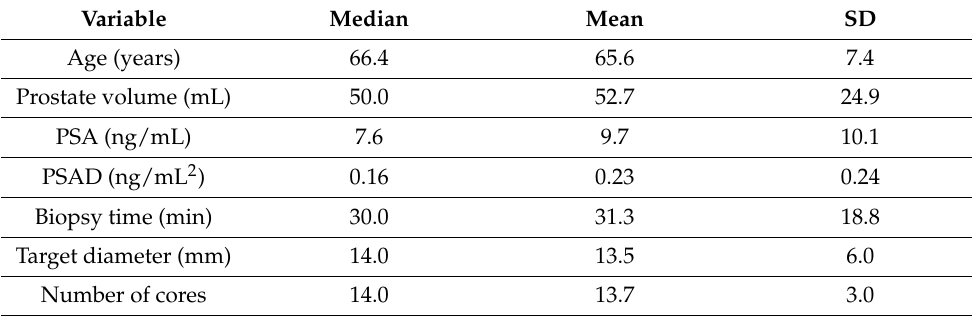
Table 1. Tabular summary of data obtained from descriptive statistics.